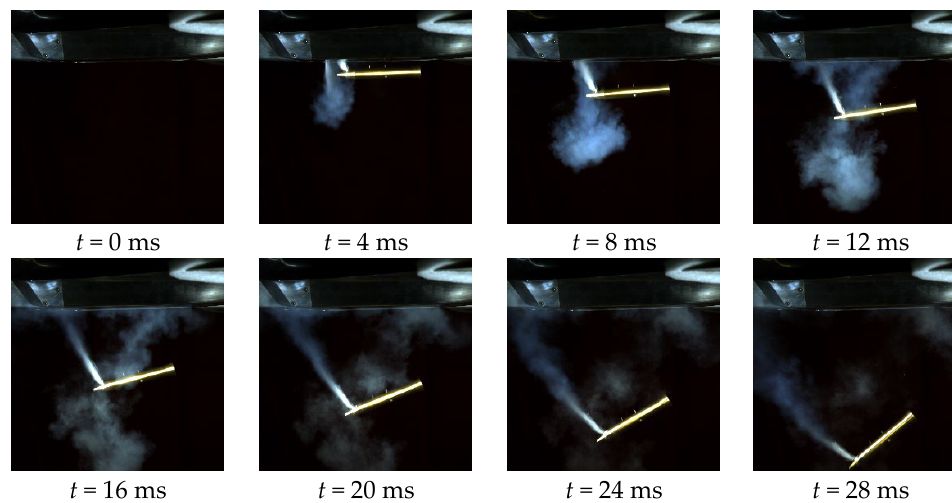
Figure 10. Test results for a 4.0 MPa jet with no wind.